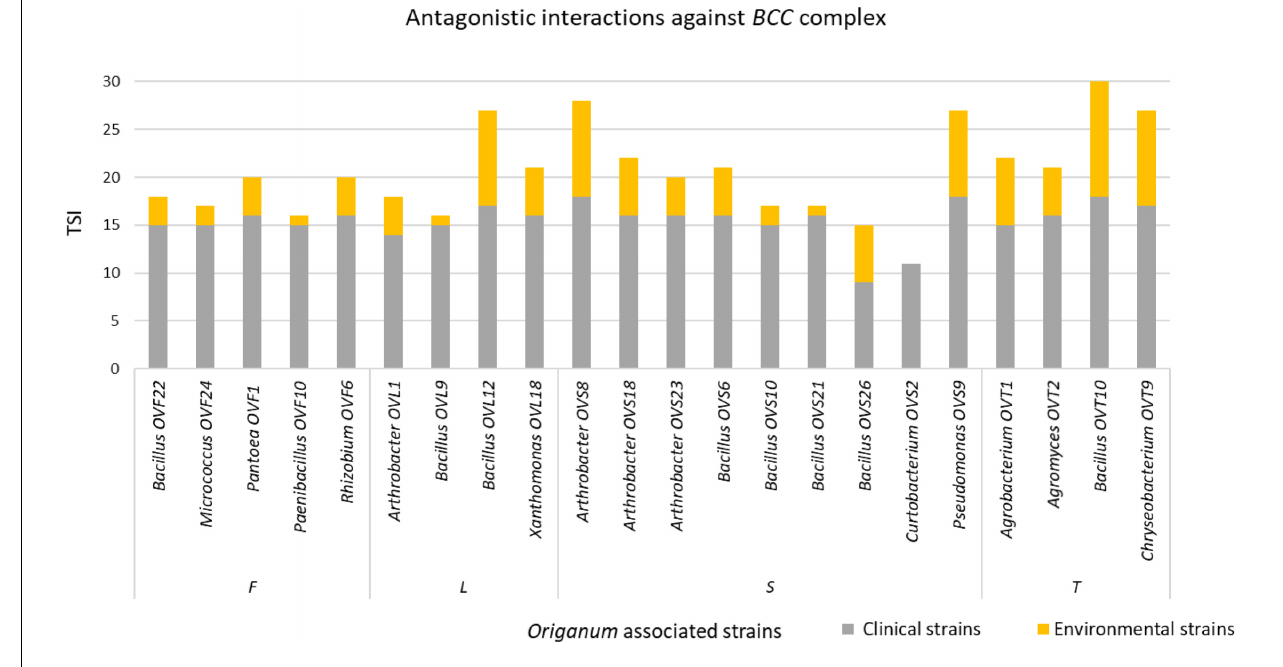
FIGURE 7 | Antagonistic interactions of O. vulgare associated strains against BCC strains.